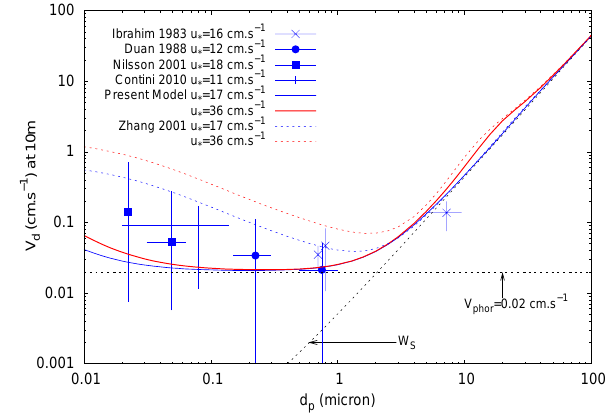
Fig. 6. Deposition on water surfaces, as measured by M¨oller and Schumann (1970); Sehmel and Sutter (1974); Zufall et al. (1998); Caffrey et al. (1998). The present model (plain) and the model of Zhang et al. (2001, dash) are run for u ∗ = 11cms − 1 (blue), u ∗ = 44cms − 1 (red) and u ∗ = 117cms − 1 (green). All deposition velocities are re-calculated at z R = 5 . 2m. The particle density is taken as ρ p = 1500kgm − 3 .